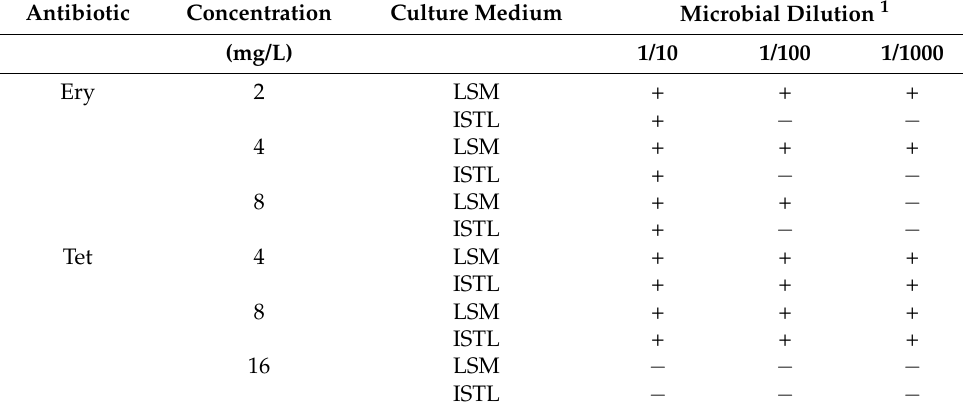
Table 2. Estimation of tetracycline and erythromycin resistance bacteria in SR56 culture. Antibiotic Concentration Culture Medium Microbial Dilution 1